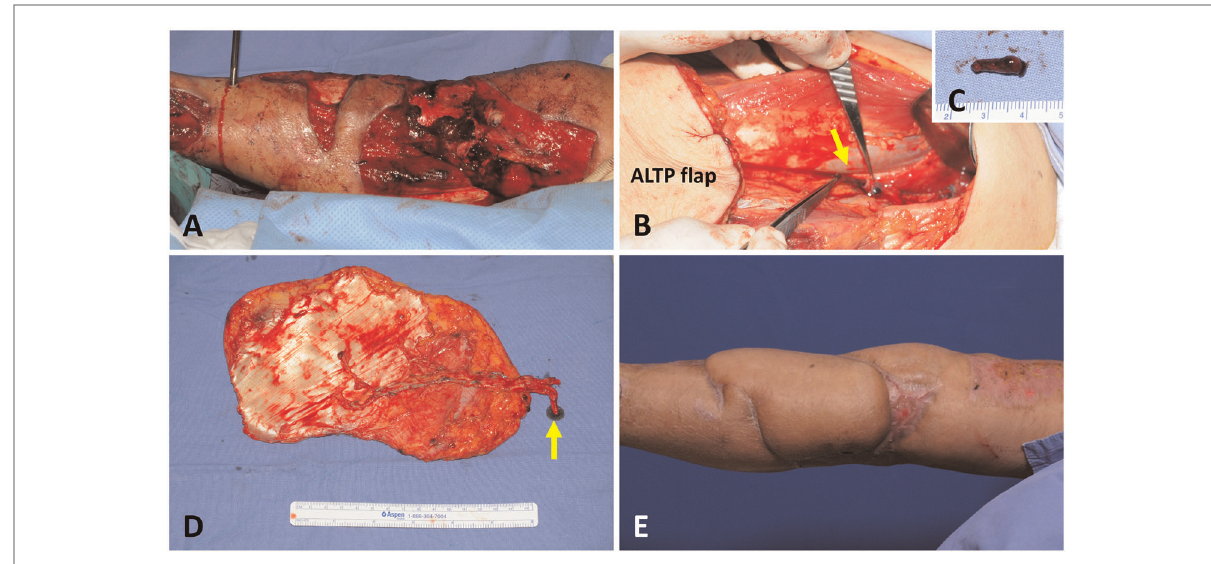
FIGURE 4 A case demonstrating DVT in one concomitant vein of DB-LCFA was discovered during the elevation of the ALTP fl ap. ( A ) A 70-year-old male suffered from a massive wound in the upper half of the calf that extended to the knee area. ( B ) DVT was found at the severed end of the one concomitant vein of the DB-LCFA. Then, the thrombus was removed with a jeweler ’ s forceps. ( C ) The removed thrombus measured 1.7 cm in length. ( D ) The ALTP fl ap was harvested with the whole DB-LCFA and its two concomitant veins (the yellow arrow indicates the concomitant vein affected by DVT). ( E ) The ALTP fl ap survived completely. DVT, deep vein thrombosis; DB-LCFA descending branch of the lateral circum fl ex femoral artery; ALTP, anterolateral thigh